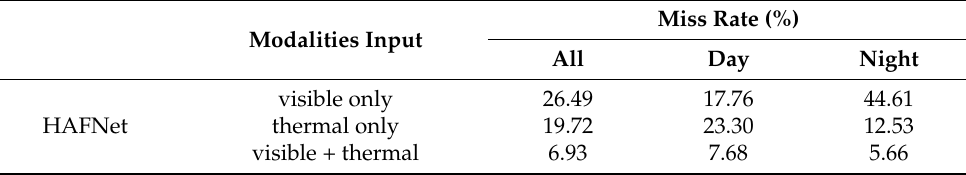
Table 9. Results of ablation experiments on single-modality and multi-modality inputs for pedestrian